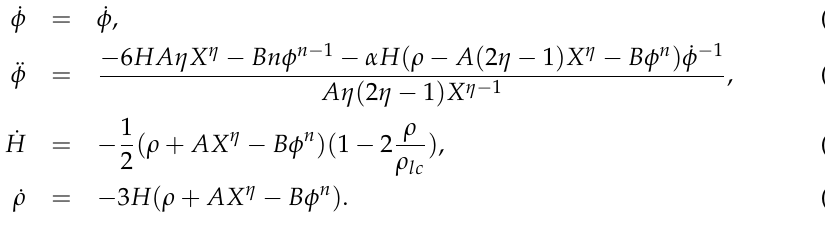
Figure 15. ( a ) The x - y phase plane projected from 3-dim system of { x , y , z } for both LQC(black) and EC(green) around P h , corresponding to the parameters of γ k = 4 , s = 4 and α = − 0.6. The initial 3 points are ( 0.5,0.2,0.1 ) for LQC, and ( 0.5,0.2,0 ) for EC. The star stands for the final state of the evolution, while the solid circle stands for the initial point. ( b ) the evolution of the cosmological quantities of Ω φ , w φ and q for both LQC(black) and EC(green) cases for P h